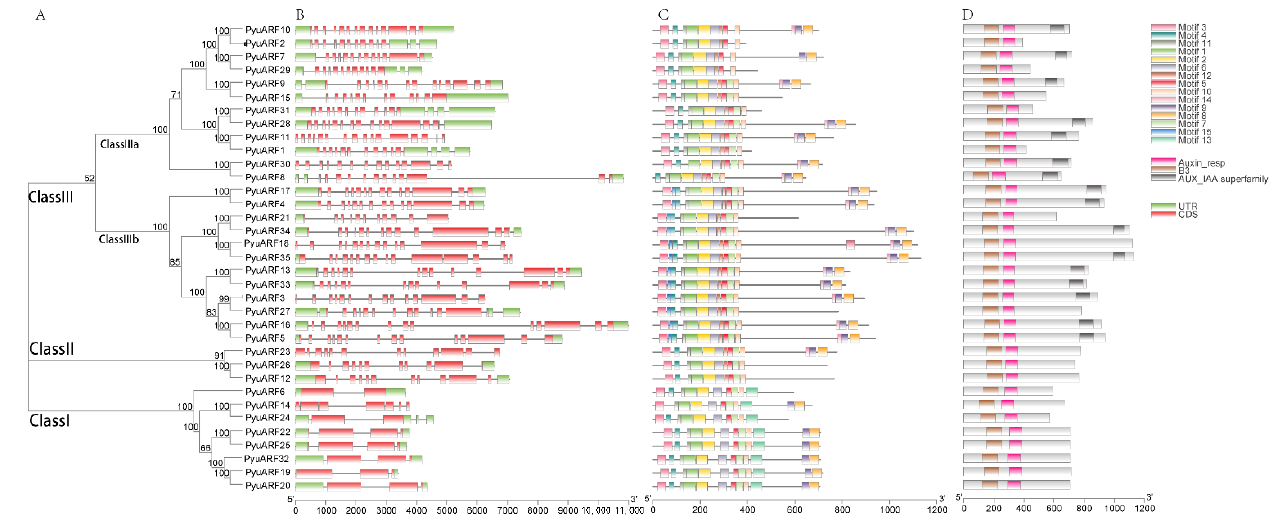
Figure 2. Analysis of the conserved ARF DNA-binding domains, gene structure, and conserved motifs depending on the phylogenetic relationships in ARF genes. A: we built the phylogenetic tree using 35 ARF proteins with the ML method. The phylogenetic tree contains three subgroups, Class I, Class II, Class III (Class IIIa, Class IIIb), shown in different colors. B: Exon/intron structure analysis of the ARF genes. Black lines, red boxes, and green boxes indicate introns, exons, and untranslated regions (UTRs), respectively. C: Conserved motifs of the ARF genes elucidated by Multiple Expectation maximizations for Motif Elicitation (MEME). The conserved motifs are represented by the different colored boxes. D: we examined the conserved ARF domains using Pfam and the Simple Modular Architecture Research Tool (SMART). Brown boxes indicate conserved ARF DNA-binding domains, blue boxes indicate conserved ARF domains, and gray boxes indicate conserved AUX/IAA domains. The scale bar of each PyuARFs is shown at the bottom of the Figure.